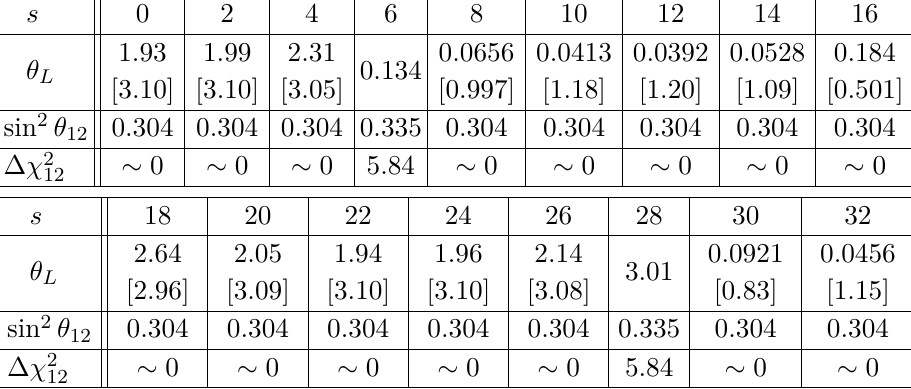
Table 7 . Case 3 a) Results for n = 34 , m = 2 and s even. The lepton mixing angles θ 13 and θ 23 are fixed to sin 2 θ 0 . 0225 and sin 2 θ 0 . 607 . We display θ , sin 2 θ and ∆ χ 2 for light neutrino 13 ≈ 23 ≈ L 12 12 masses with NO. We write ∼ 0 when ∆ χ 2 < 10 − 3 . The presence of a second best fit value for θ L is 12 indicated in square brackets. These results can also be found in [22], see Case 3 a) with n = 17 and m = 1 .